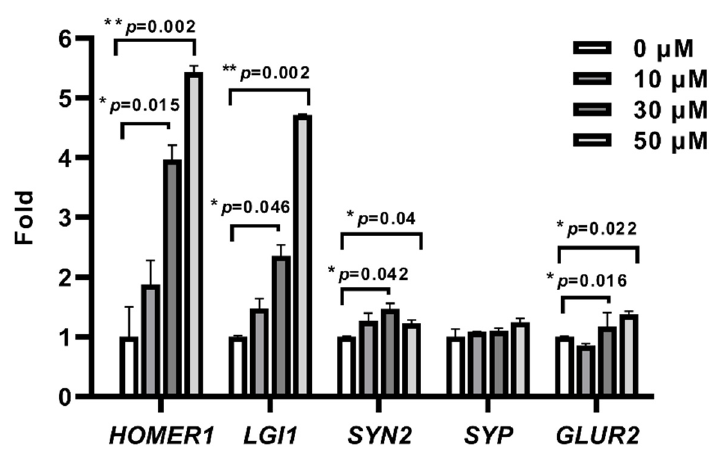
Figure 3. Quantitative RT-PCR analysis of neuron and plasticity-related genes in differentiated FAD cells after 48 h exposure to an increasing concentration of Tasquinimod. Data are expressed as mean ± SEM. * p < 0.05, ** p < 0.01 by Student’ t -test. Significant increase relative to 0 µ M (vehicle control).